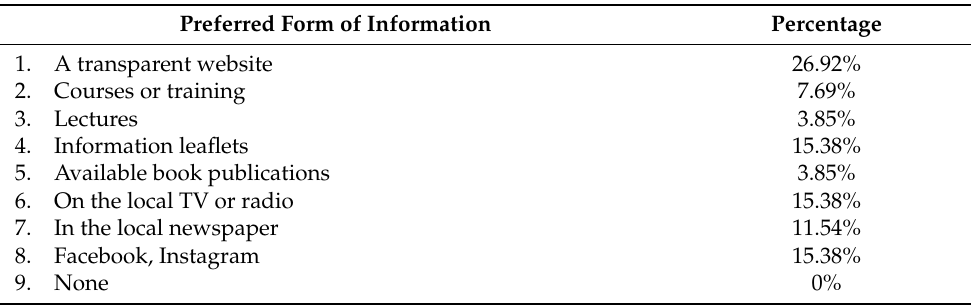
Table 9. Preferred form of information about civil protection and population protection in the category of secondary education without the graduation